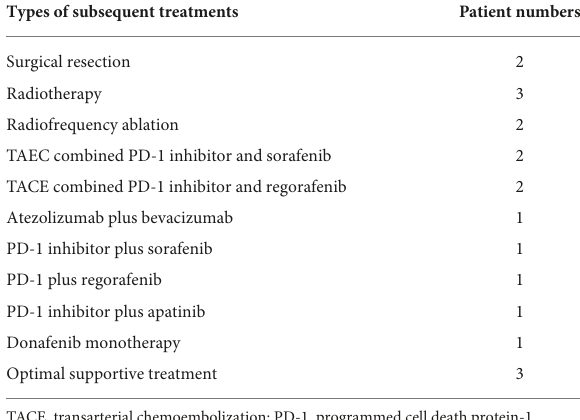
TABLE 4 Summary of best